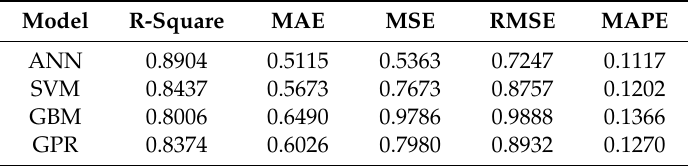
Table 5. Forecasting performance of four machine learning